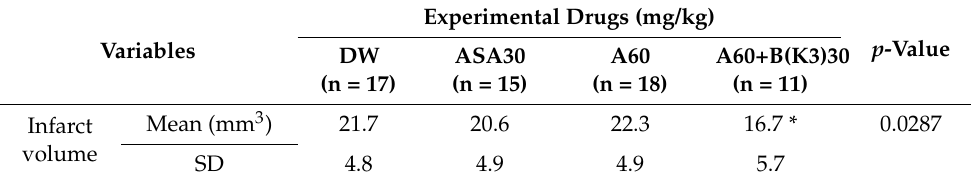
Table 7. Effects of experimental drug A60+B(K3) 30 mg/kg on infarct volume after pMCAO.